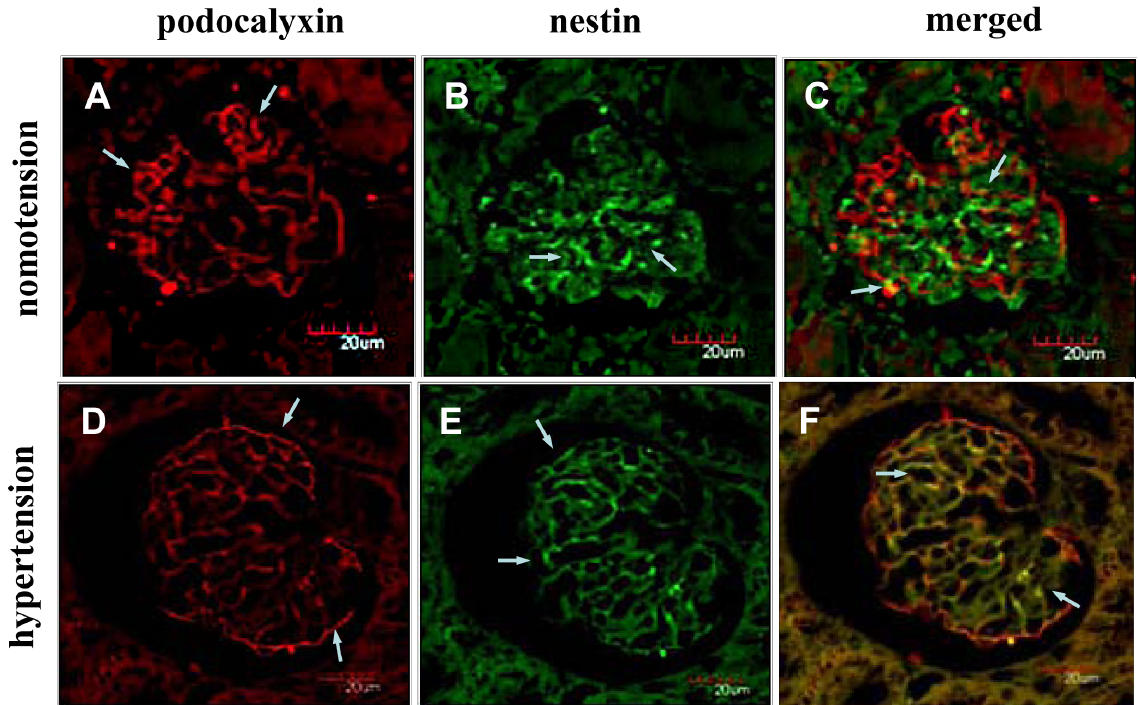
Figure 4. Immunofluorescence micrographs for PCX and nestin under various hemodynamic conditions. Confocal laser scanning micrographs show the double-fluorescence of PCX (red color) and nestin (green color). Under the normotensive condition, PCX showed an intense epithelial staining along the peripheral capillary loops of the glomeruli ( A ), and nestin showed an intense endothelial staining and a weaker appearance in the podocytes ( B ). Under the acute hypertensive condition, the immunoreactivity of PCX was decreased ( D ), and nestin immunolocalization was almost completely restricted to the podocytes ( E ). Under the cardiac arrest condition, the immunoreactivity of podocalyxin and nestin was reduced visibly compared with the normotensive condition, and nestin was restricted to the podocytes ( G , H ). The double-staining micrographs are shown in C (normotension), F (acute hypertension) and I (cardiac